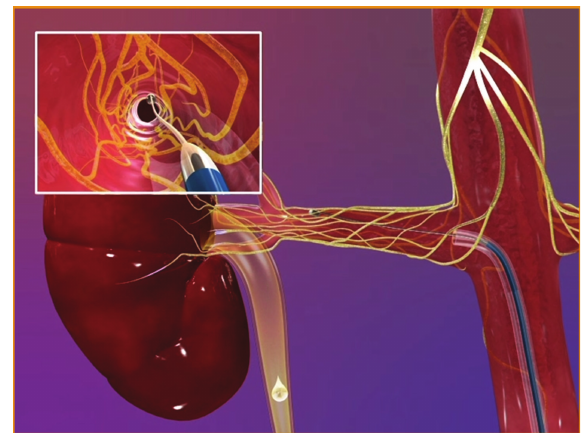
Ability to p e r sonalize and cont r ol the the r a p y